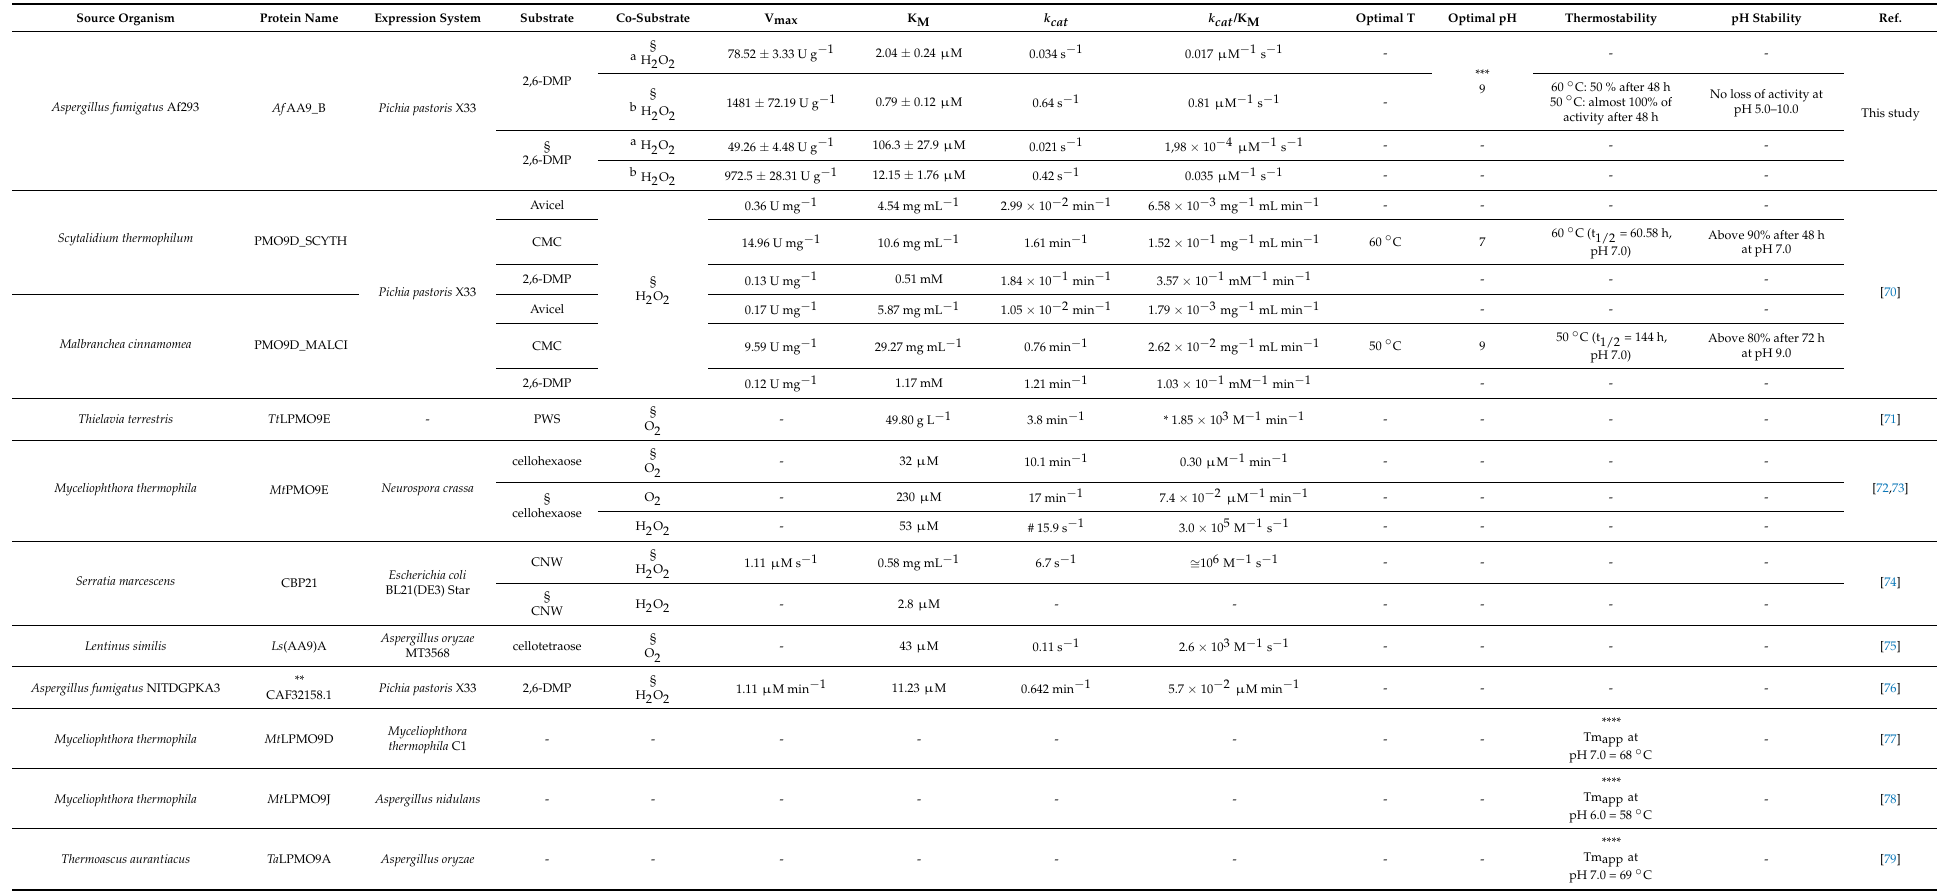
Table 3. Comparison among catalytic and biochemical properties of